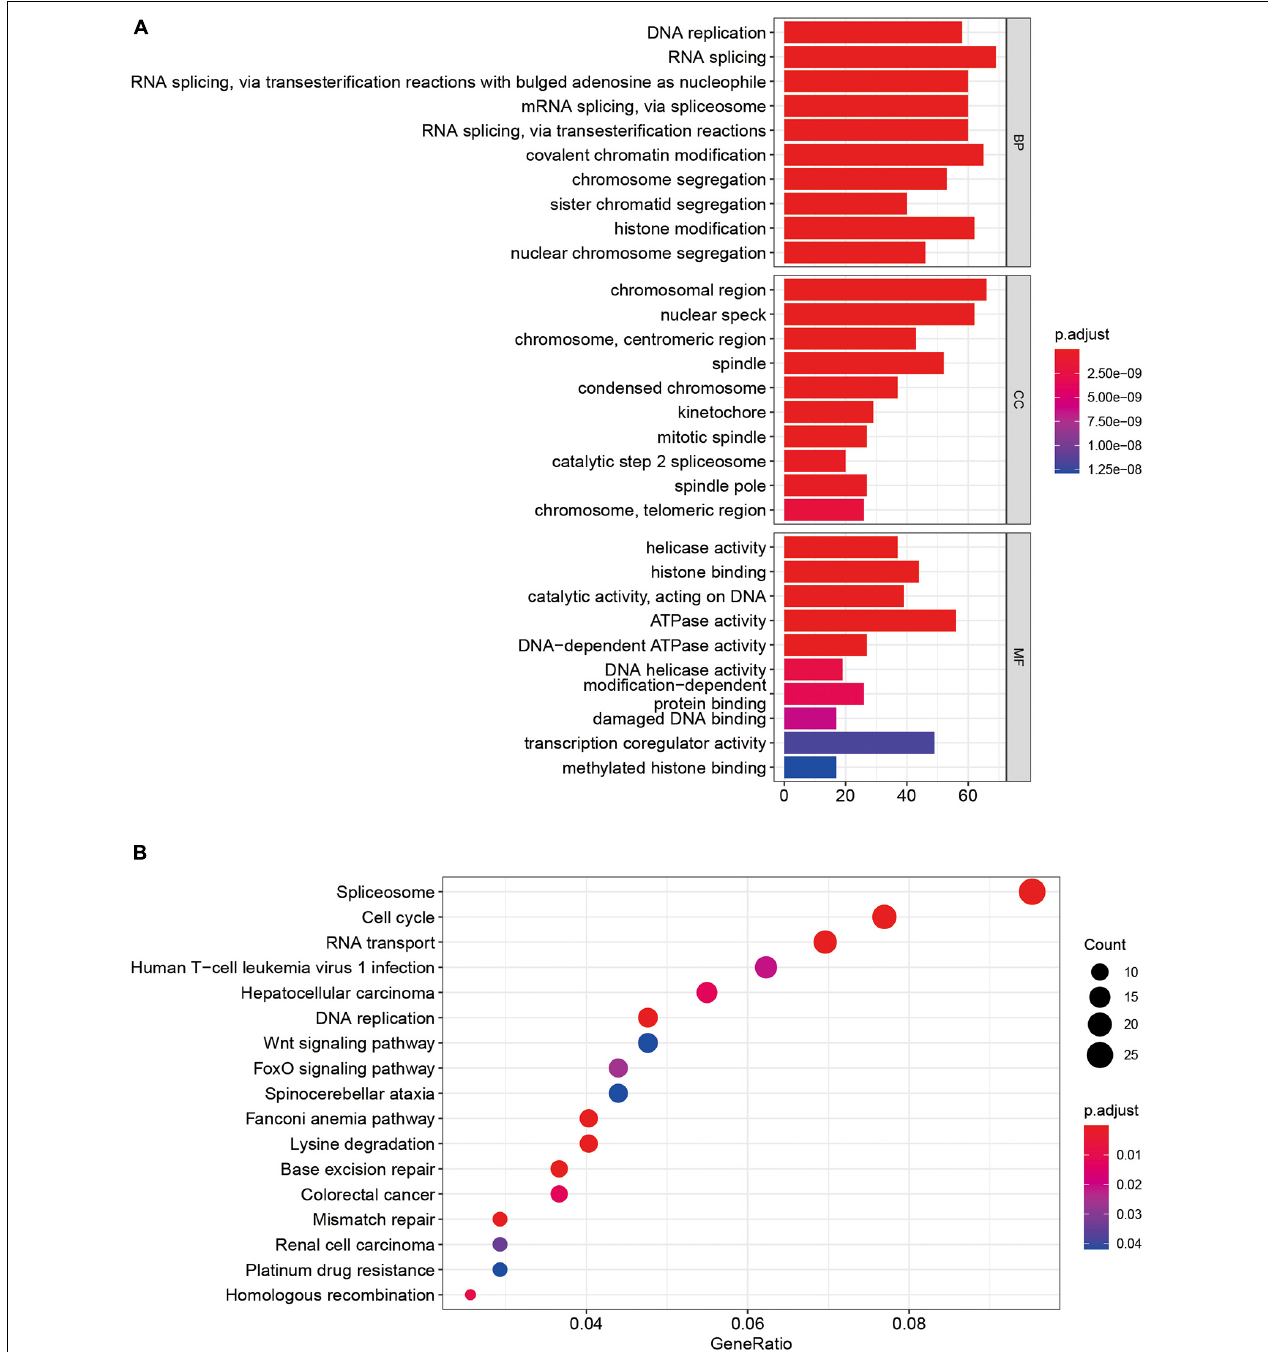
FIGURE 5 | GSEA of SUMOylation regulators in OSCC. (A) GO analysis. (B) KEGG